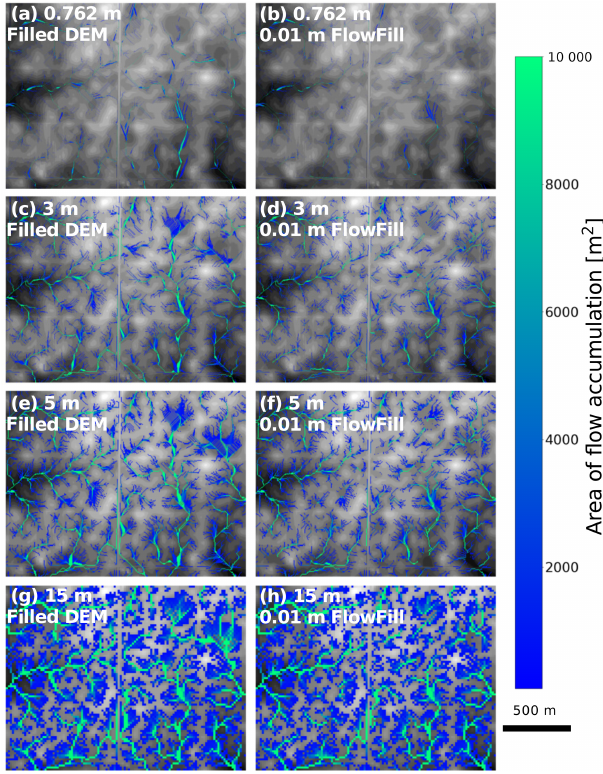
Figure 12. Depths of unfilled depressions in a subsection of the Sangamon study area at several different resolutions. The left col- umn shows depressions existing in the unfilled DEM, and the right column shows remaining depressions after running FlowFill with 1cm of starting runoff. (a) The unfilled DEM at 0.762m (2.5ft) resolution, (b) the 0.762m resolution results after running Flow- Fill with 1cm of starting water, (c) 3m resolution unfilled DEM, (d) 3m resolution after running FlowFill, (e) 5m resolution unfilled DEM, (f) 5m resolution after running FlowFill, (g) 15m resolu- tion unfilled DEM, and (h) 15m resolution after running FlowFill. DEM elevations are shown in greyscale, from dark (low) to light (high), while blue and green indicate the locations of depressions still present in the flow-routing surface. Resampling to coarser res- olutions creates the visual impression of increasing the number of depressions since more large depressions are visible, but in real- ity the total number of depressions decreases as finer resolutions contain many small depressions, which are lost at coarser resolu- tions. The results after using FlowFill appear visually similar, with the exception of the 15m resolution DEM, in which several larger depressions along the southern margin were filled. Table 3 reveals that hundreds to thousands of less visible, smaller depressions were filled at finer resolutions.